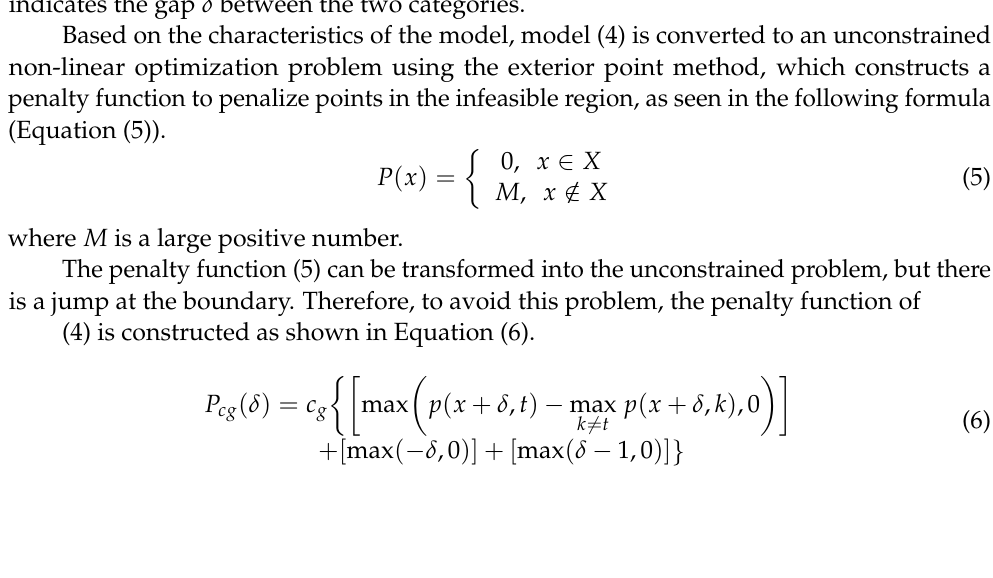
Figure 2. The relationship between the adversarial image and the original image. Figure 2 shows that there is an area gap between the two different categories. The red and blue dashed circles represent the feasible region X = and initial solution X 0 = { x | x ∈ p ( x , t ) } of the model (4), respectively. The black dashed line indicates the gap δ between the two